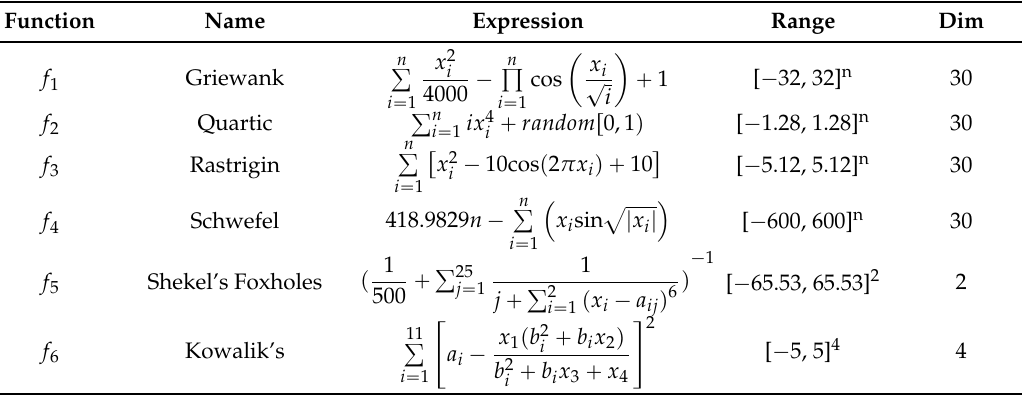
Table 1. Typical test functions.